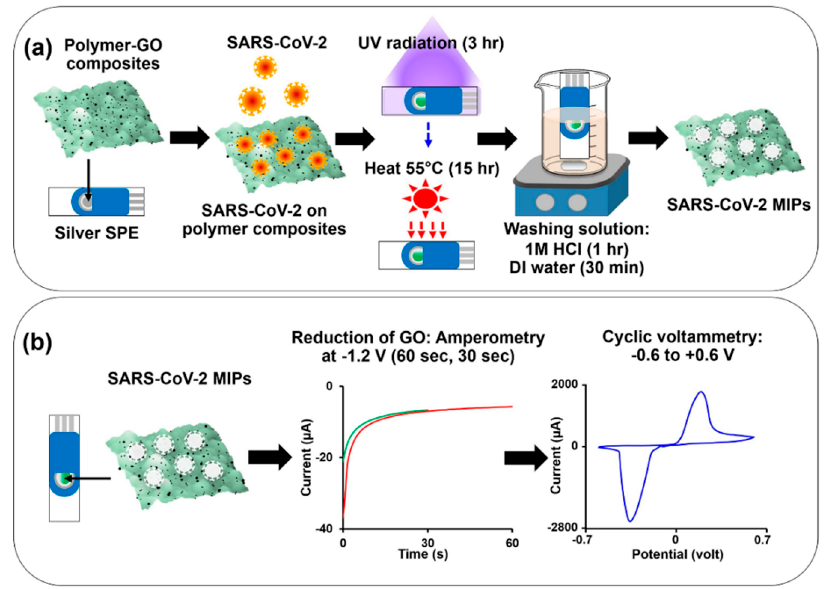
Figure 4. Schematic representation of ( a ) the preparation of MIP-based sensor and ( b ) the electro- chemical reduction of graphene oxide Reprinted with permission from [141]. 2022, Elsevier.